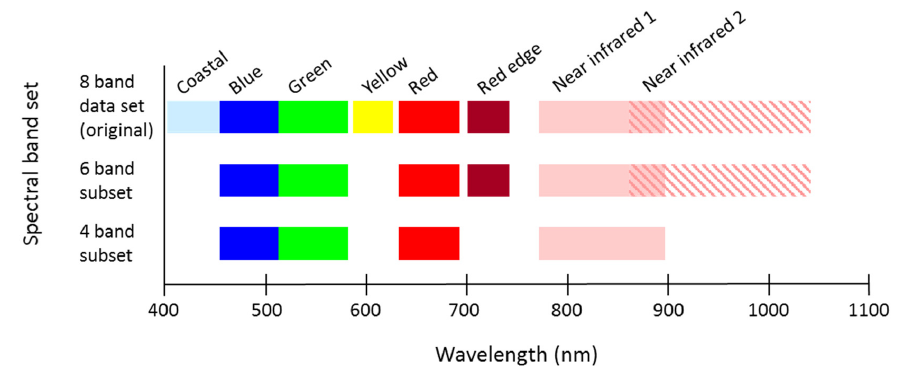
Figure 2. WorldView-2 spectral wavebands (top line) and spectral band subsets used for comparative